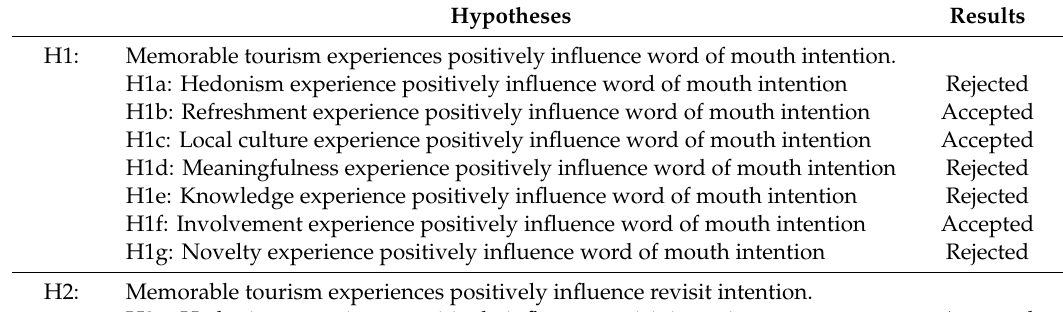
Table 4. Results of hypothesis